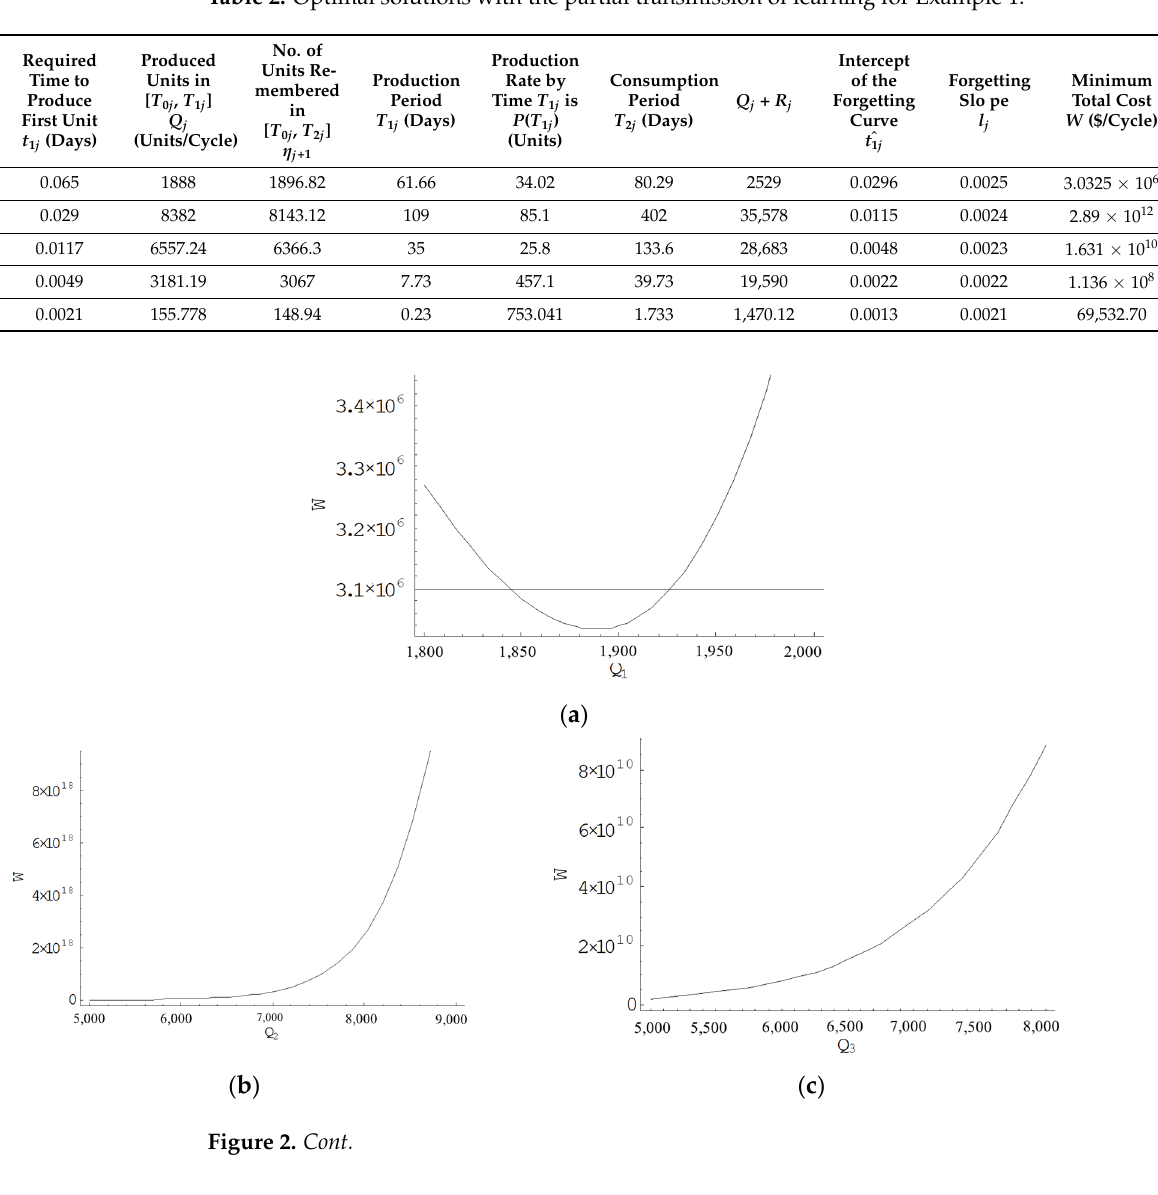
Table 2. Optimal solutions with the partial transmission of learning for Example 1.